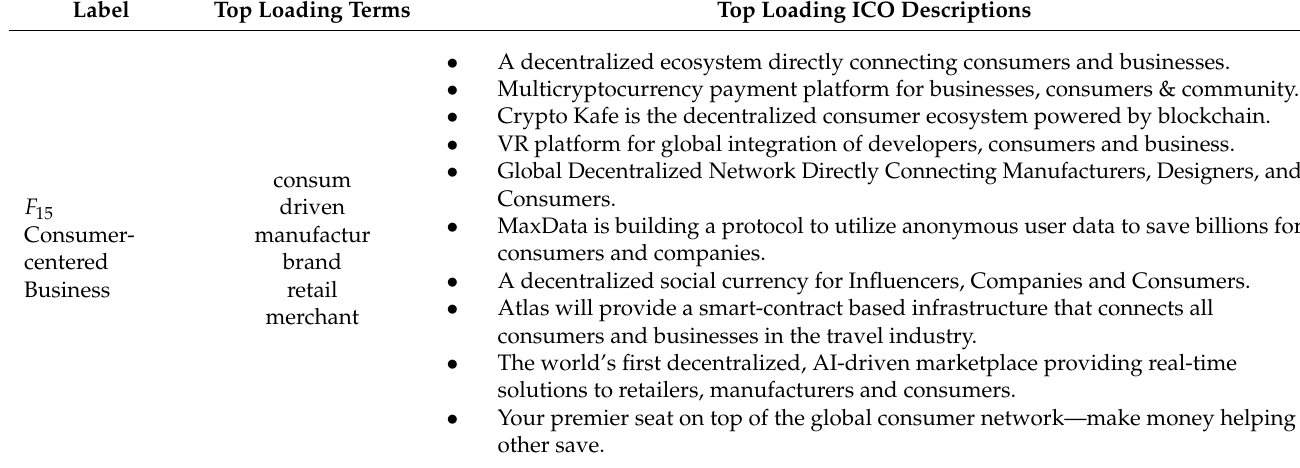
Table A15. Consumer-centered Business.